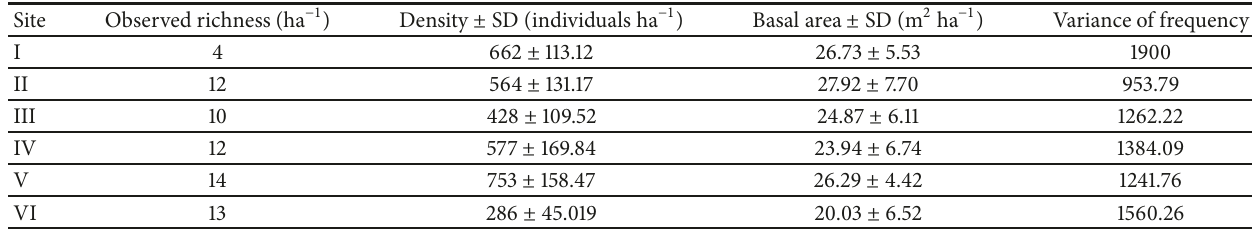
Table 4: Observed richness, total density, and total basal area along the sites of Musharni Mai BZCF. Site Observed richness (ha −1